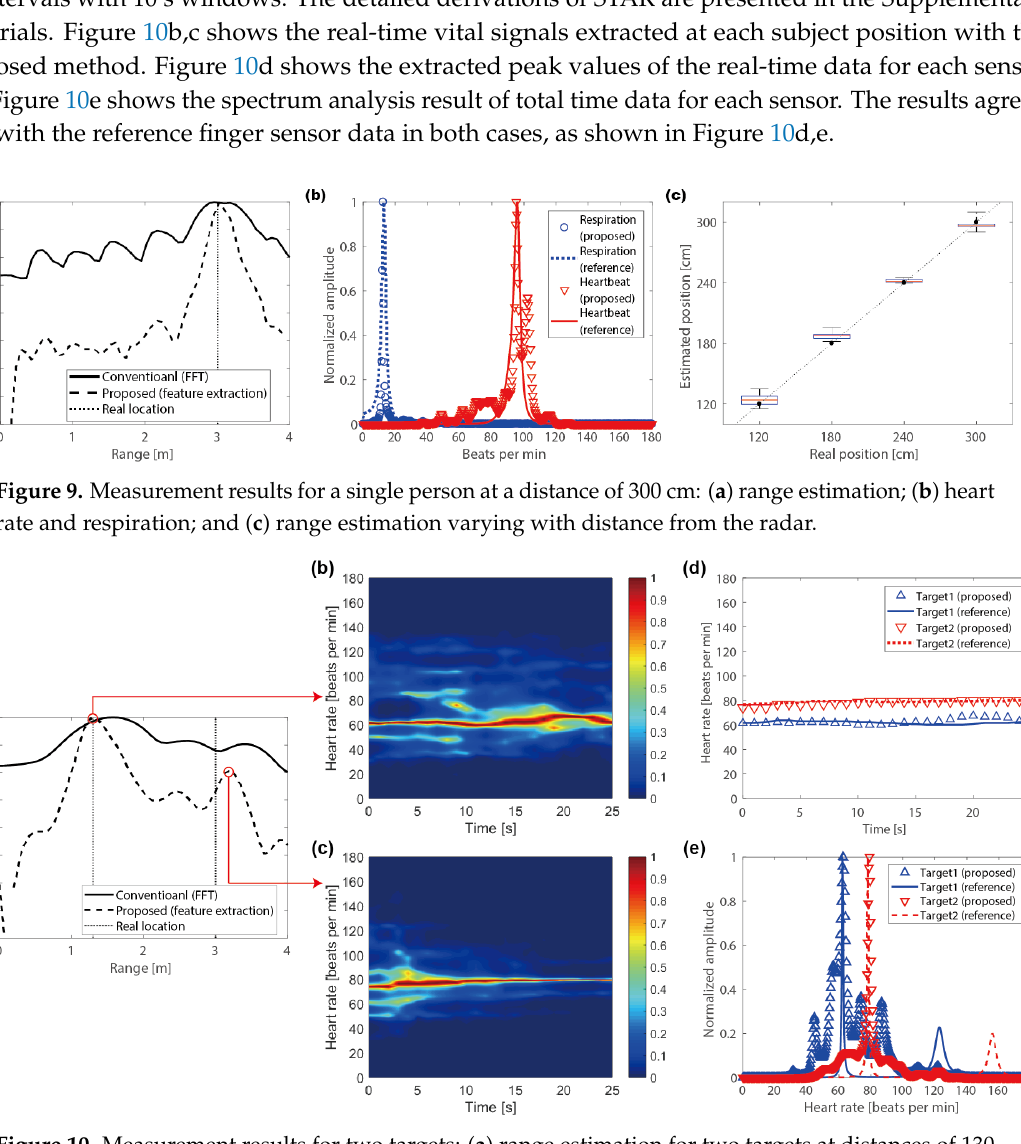
Figure 10. Measurement results for two targets: ( a ) range estimation for two targets at distances of 130 to 300 cm; ( b ) real-time heart rate for the front target at a distance of 130 cm; ( c ) real-time heart rate for the rear target at a distance of 300 cm; ( d ) comparison between the proposed method and the reference sensor in real-time data; and ( e ) comparison between the proposed method and the reference sensor in terms of the total